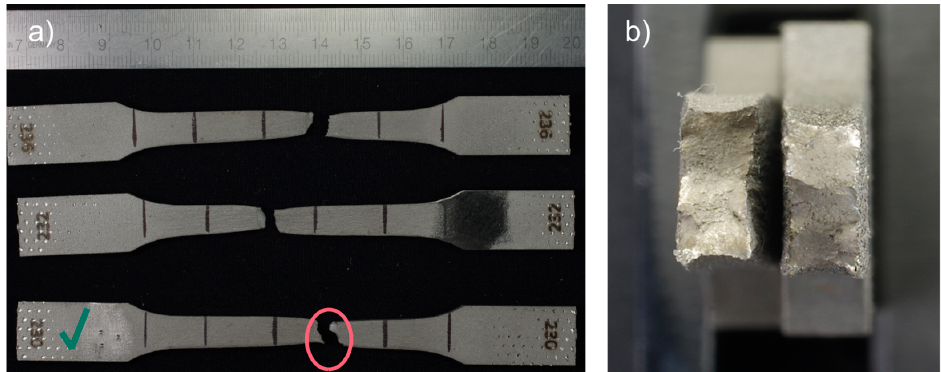
Figure 9. Fractures of tensile test EOS M 290 316L (HT) specimens presented as: ( a ) fractured specimens; ( b ) optical microscope image of the fracture surfaces, specimen 230. The samples have been numbered, which are visible in the figure. The letters L and R stand for the left-hand and right-hand sides of the sample in the figure. A green check mark means the specimen whose fracture faces were shown.